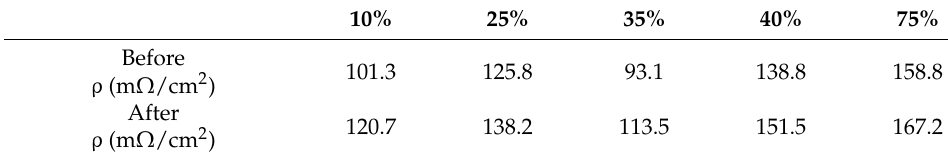
Figure 5. EIS of 10%, 25%, 35%, 40%, 75% CQDs/G after cycle. Table 1. Resistivity of 10%, 25%, 35%, 40%, 75% CQDs/G before and after